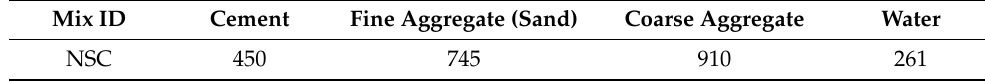
Table 1. Mix proportion of NSC (kg/m 3